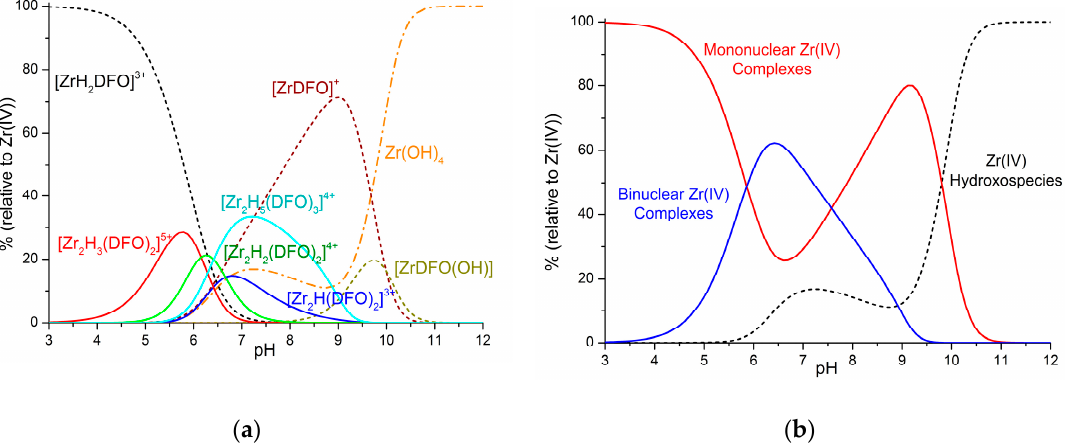
Figure 3. Distribution diagrams of the complexes formed in the Zr 4 + –H 3 DFO system ([Zr 4 + ] = [L] = 100 nM). ( a ) Diagram of individual species. Solid lines: Binuclear species; dashed lines: Mononuclear species; dash–dot lines: Zr 4 + hydroxo species. Only species formed with percentages of formation higher than 2% are reported. ( b ) Diagram with overall percentages of mononuclear, binuclear, and hydroxo complexes. Distribution diagrams were obtained by means of the Hyss program [15] on the basis of the determined equilibrium constants.